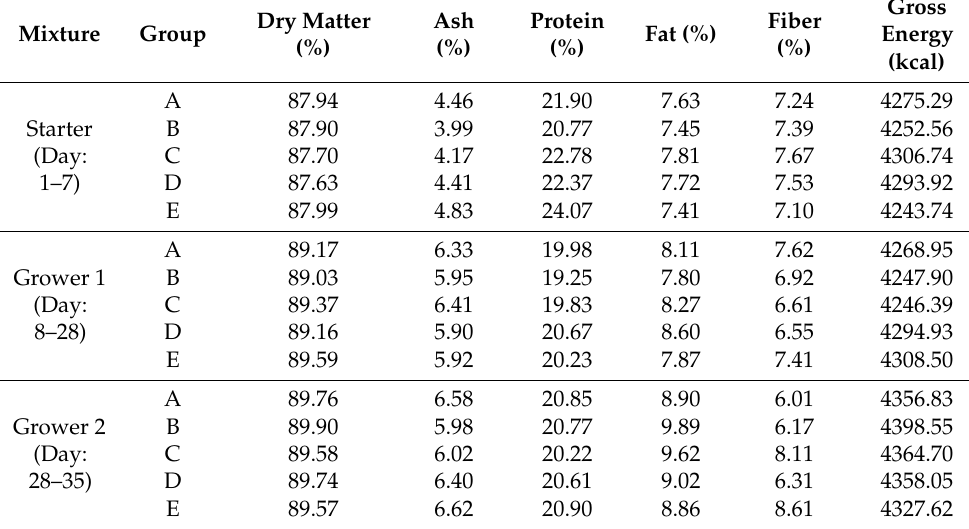
Table 1. Nutritional composition of experimental